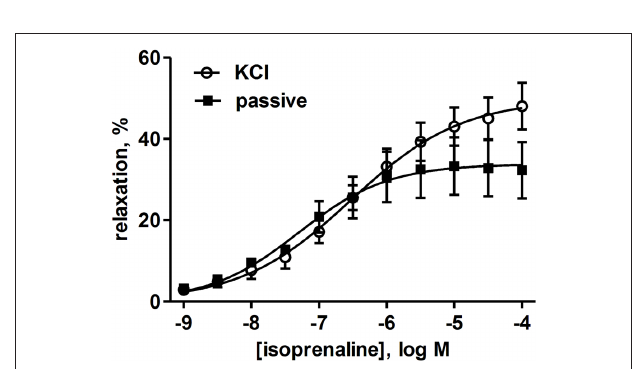
Figure 4 | relaxation of human detrusor strips by isoprenaline under passive tension (filled squares) or with tone induced by KCl (open circles). Data are means ± SEM of five patients for which both conditions were studied in parallel on day 0 or 1 with 3–4 strips per patient. For quantitative analysis see main